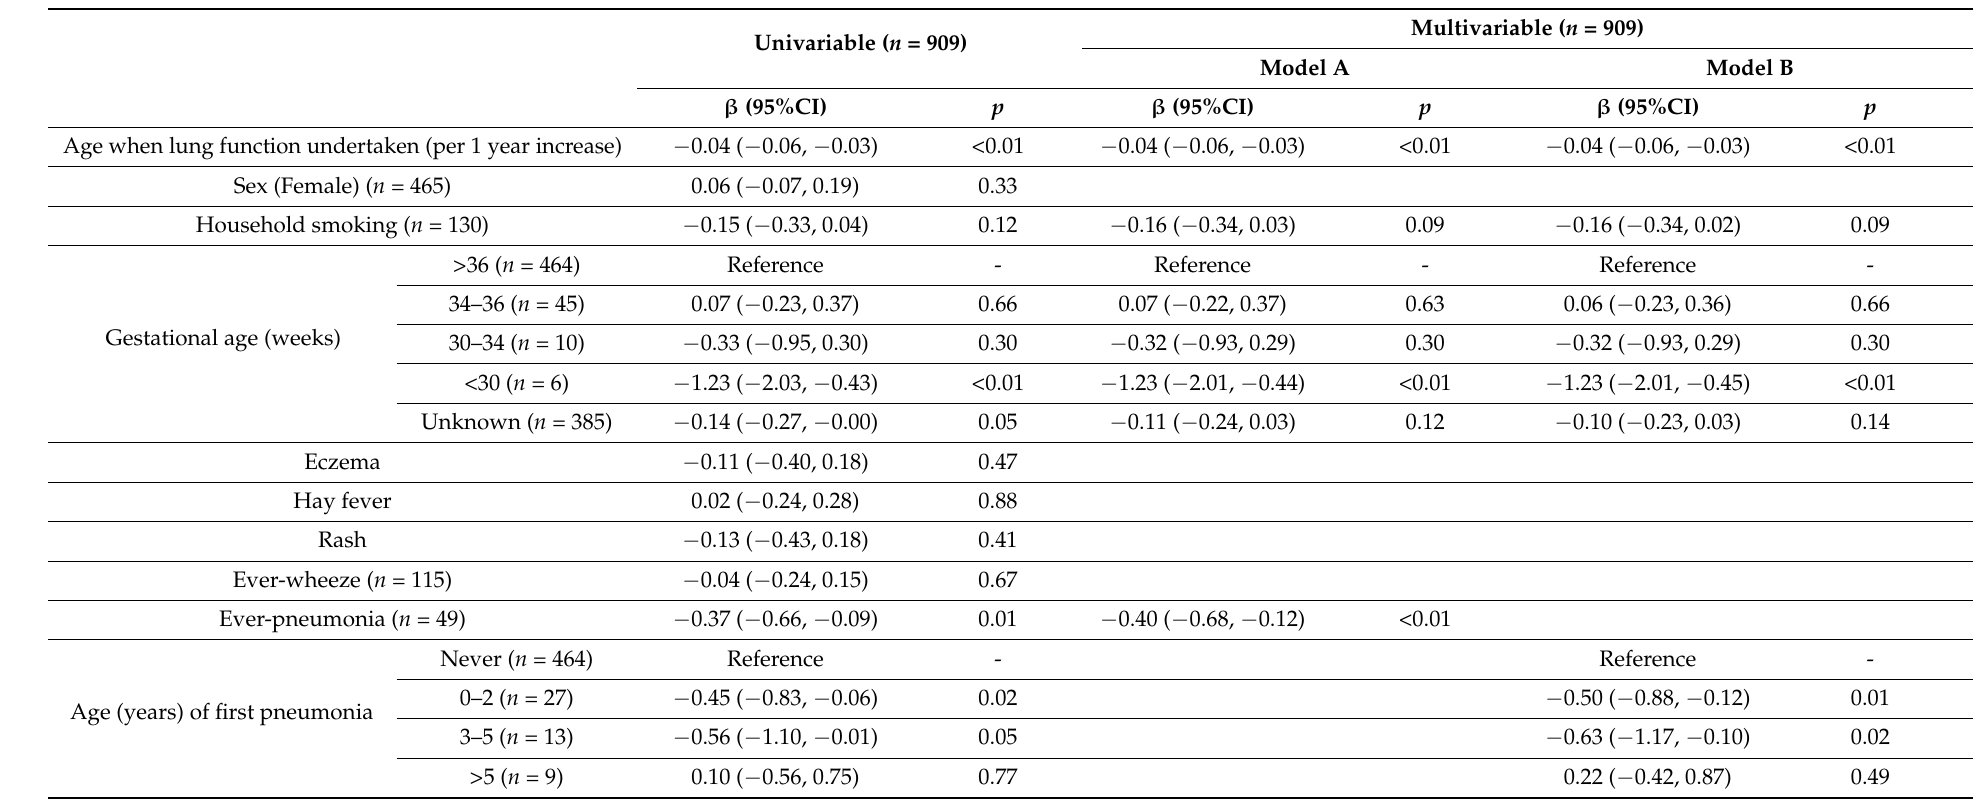
Table 3. Univariable and multivariable regression modelling of FVC Z-scores in 909 First Nations